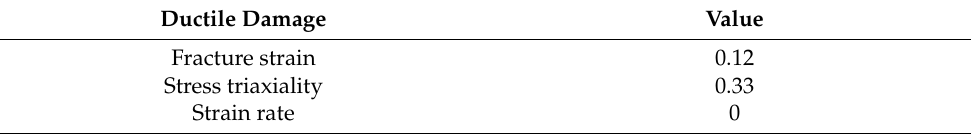
Table 2. Ductile damage parameter. Figure 2. Stress-strain curve of GH4169 obtained from the test.